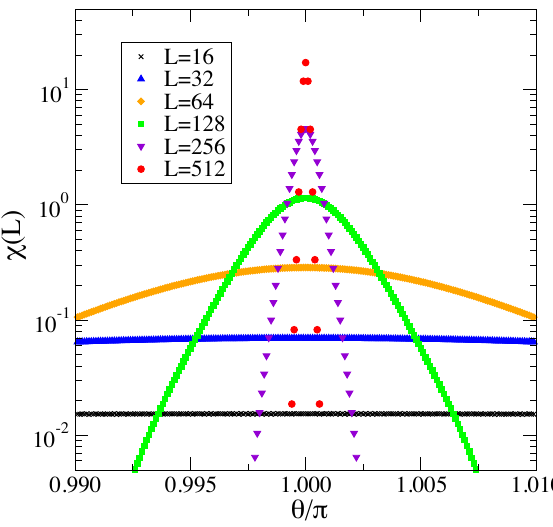
Figure 4 . Topological susceptibility (cid:31) ( L ) as a function of (cid:18) with 16 (cid:20) L (cid:20) 512.